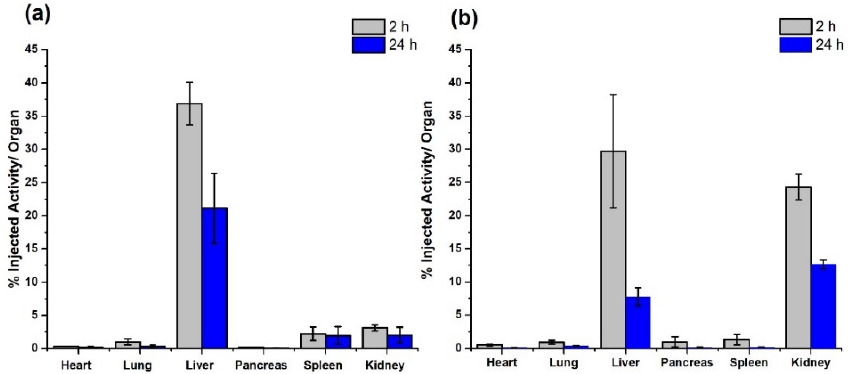
Figure 7. Biodistribution profile in mice (% injected activity/organ) of ( a ) HYNIC-rHDL and ( b ) DOTA-rHDL nanoparticles after 2 and 24 h of administration.